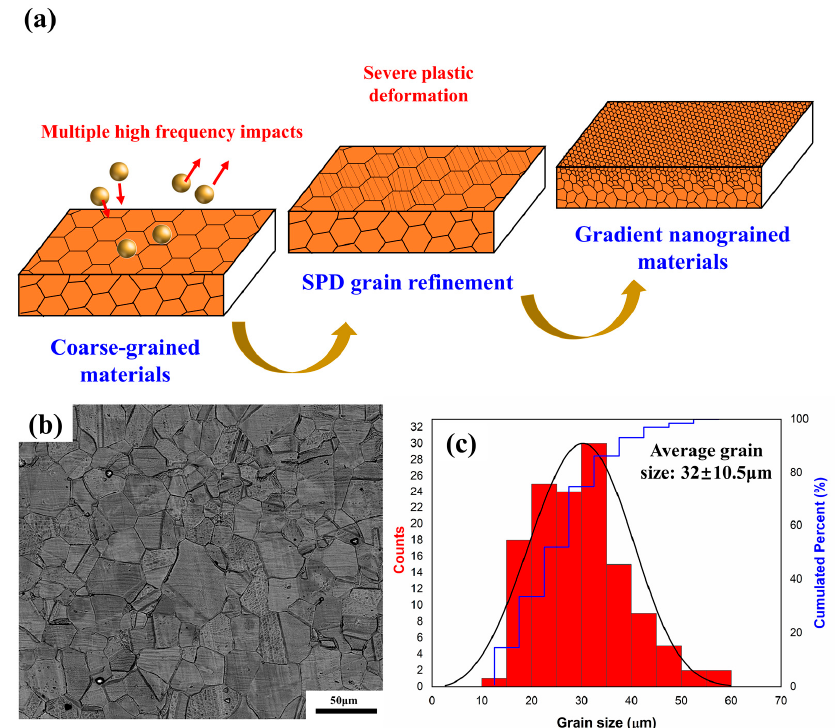
Figure 1. Principle of the ultrasonic shot peening process and the initial condition of the as-received matrix materials: ( a ) scheme of the surface nanocrystallization of 316L stainless steel by ultrasonic shot peening; ( b ) SEM characterization of the as-received coarse-grained 316L stainless steel; ( c ) statistical analysis of the grain size distribution of the coarse-grained 316L stainless steel.